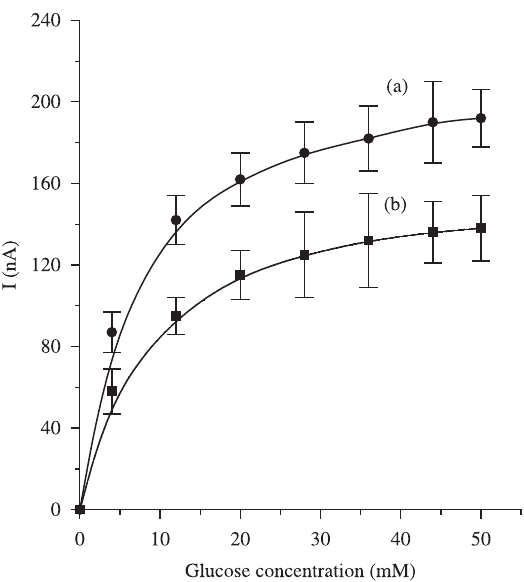
Figure 5. The relationship between response current and glucose concentration for the PGLD (a) and CHD (b) biosensors in 0.1 M NaPBS and pH 7.0 at 37 °C. The error bars represent standard deviations between five